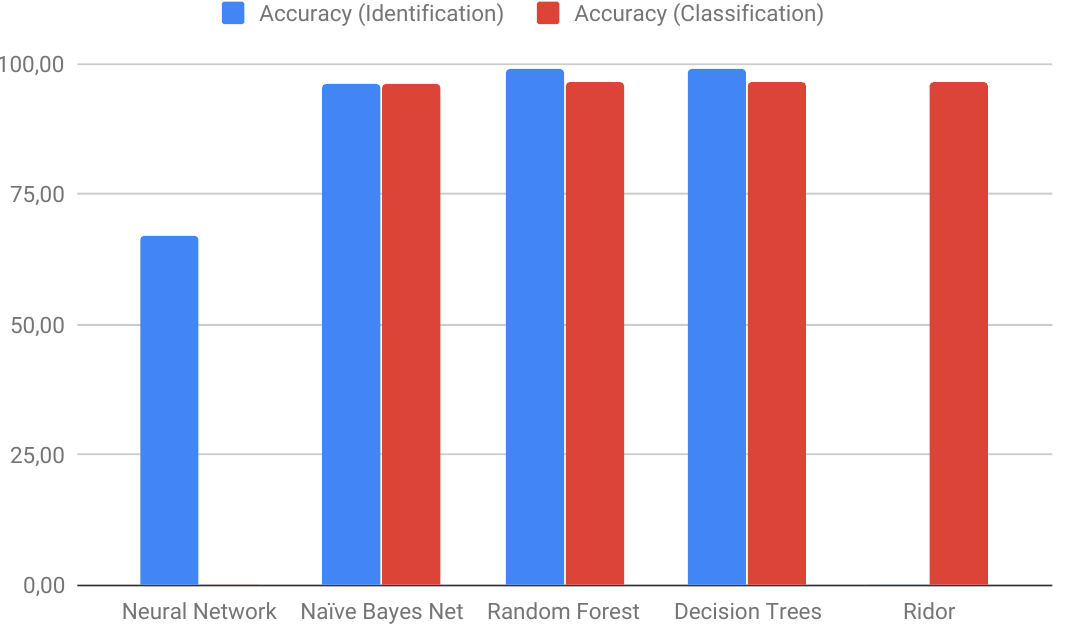
Figure 7. Accuracy of machine learning (ML) algorithms tested for TE identification and classification problems. A Neural Network and Ridor were used for only one problem. Adapted from Loureiro et al. [170]. Table 7. ML algorithms tested by Loureiro et al. [170] in TE identification and classification problems.